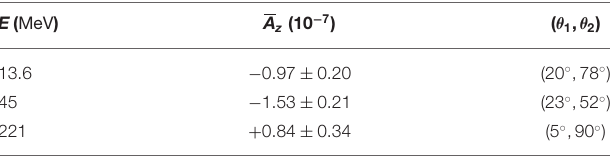
TABLE 4 | Values of A z and angle ranges for the three measurements of the longitudinal analyzing power [215, 217, 218].